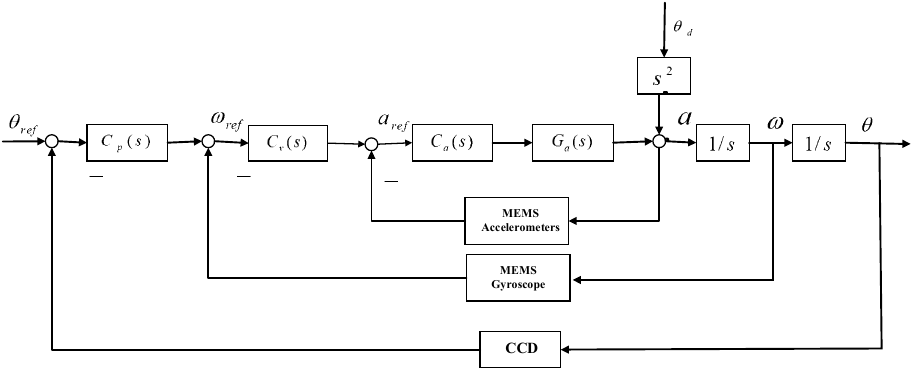
Figure 2. Diagram of a three closed-loop feedback control system.